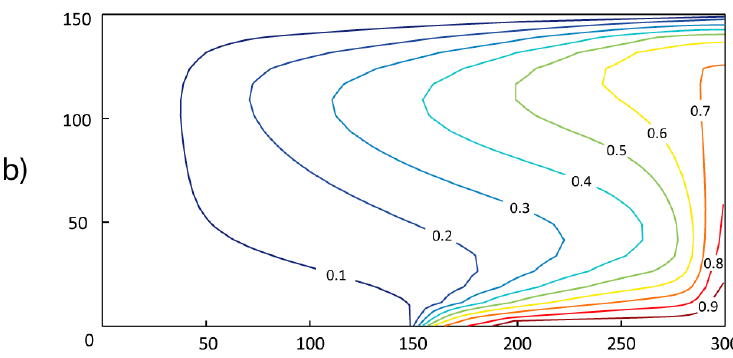
Figure 7. Steady state temperature patterns for the elder problem: ( a ) case 1; and ( b ) case 2.